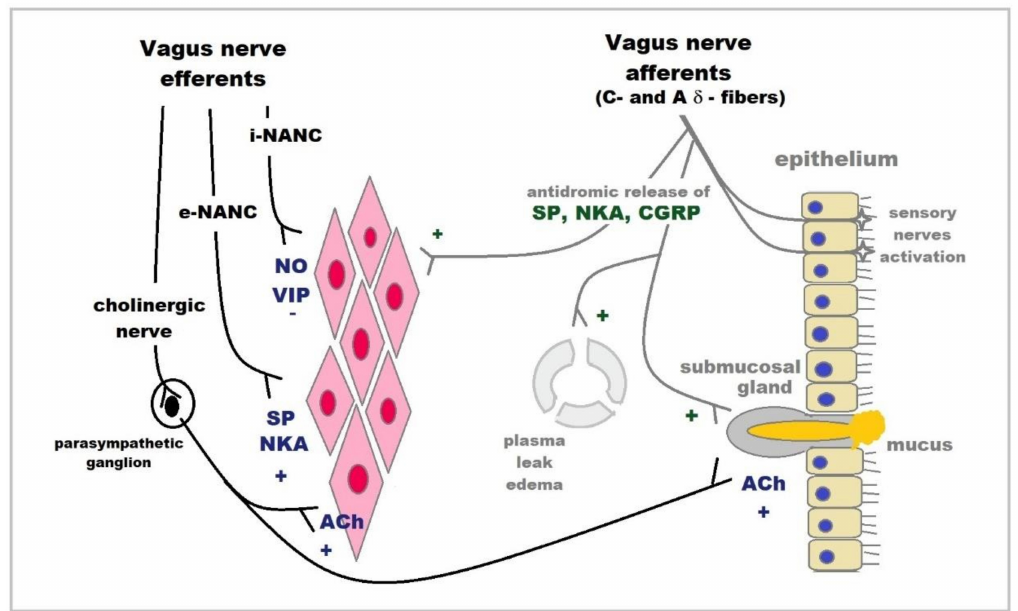
Figure 2. Neuropeptides secreted by i-NANC (VIP) and e-NANC (SP, NKA) efferent fibers of the vagus nerve and returning collaterals of vagus nerve sensory fibers (SP, NKA and CGRP) in the course of asthma; ( − ) means smooth muscle retraction and bronchodilation; (+) means smooth muscle contraction, bronchoconstriction, mucus hypersecretion, plasma exudation and